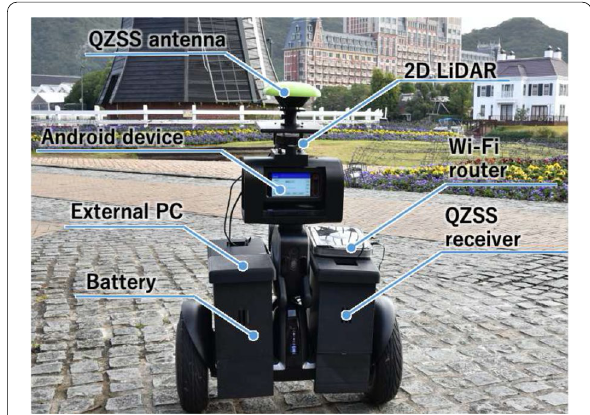
Fig. 16 Qurin: the first version of the robot system. This robot uses a standard Wi-Fi network